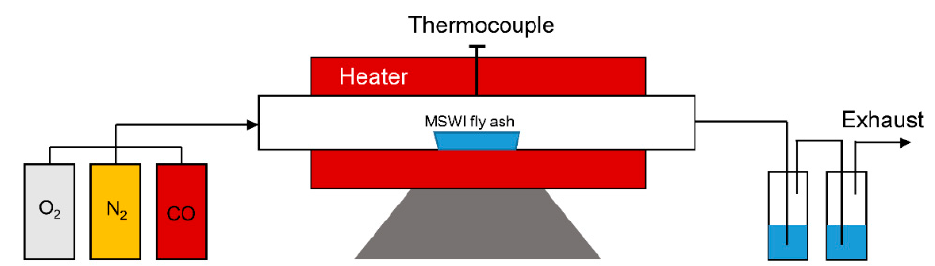
Figure 2. Schematics of the horizontal furnace.